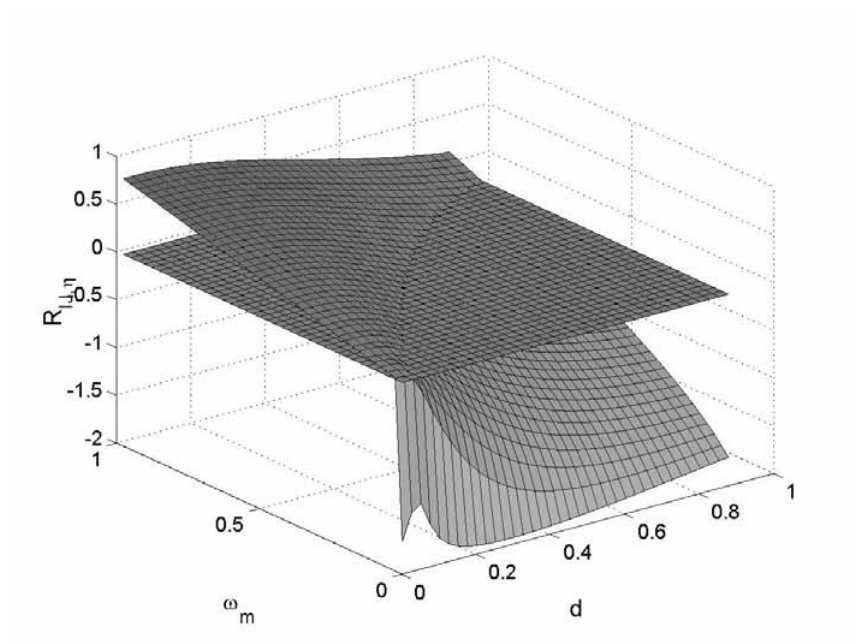
Fig. 19. Definition of the line of minima.